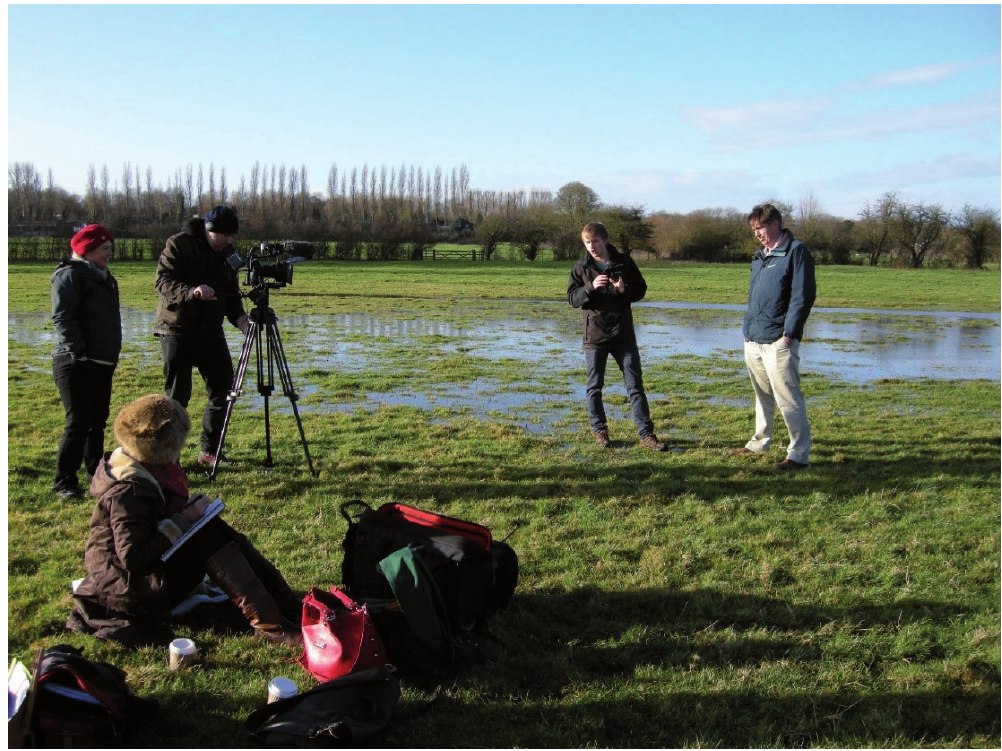
Figure 4: Filming expert opinion about the societal and economic impacts of research into carbon capture and storage in lakes and floodplain